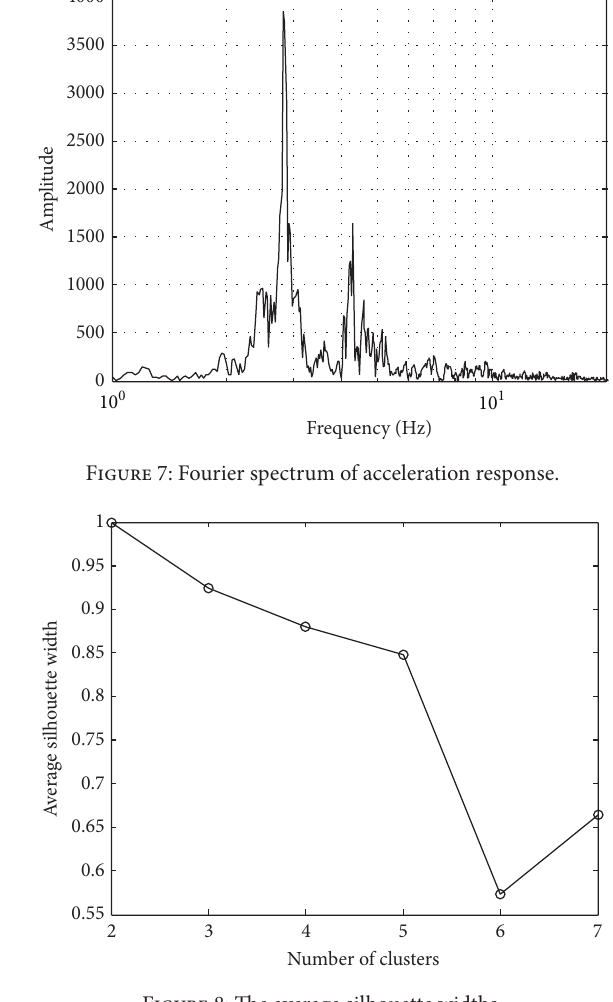
Figure 8: The average silhouette